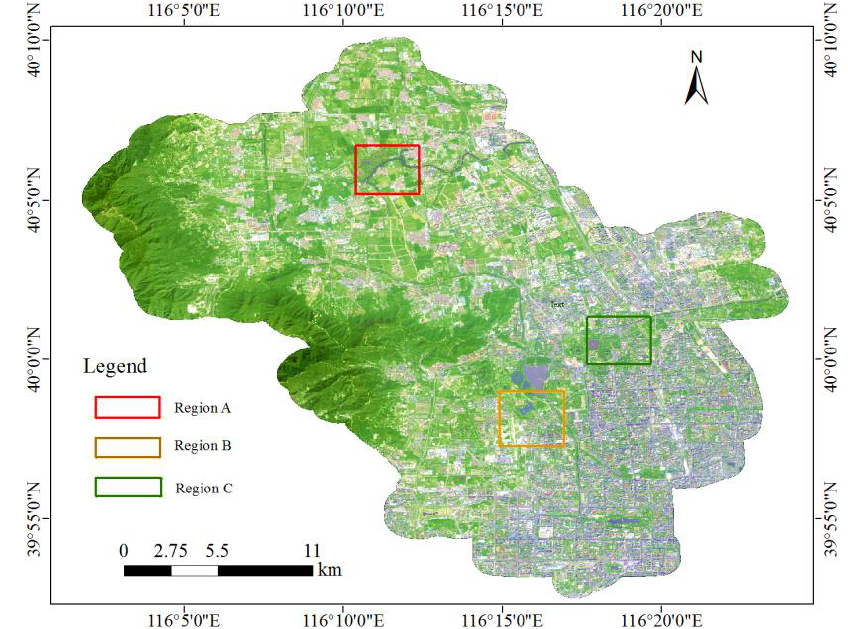
Figure 1. Pre-processed Beijing-2 image over Haidian District with test regions marked as A, B, and